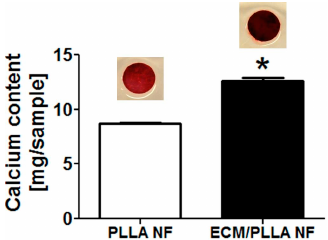
Figure 6. Calcium deposition on PLLA NF and ECM/PLLA NF after mBMSCs culture for 14 days: inserted images were Alizarin Red S staining of calcium. Calcium deposition were significantly higher on ECM/PLLA NF than on PLLA NF ( p < 0.05) after 14 days. * indicates significant differences.